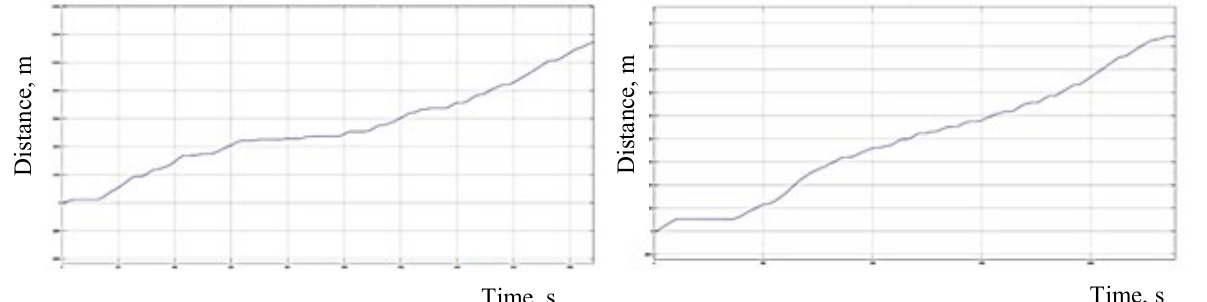
Fig. 5. Distance for routes No. 5 and No. 2 calculated in the model.